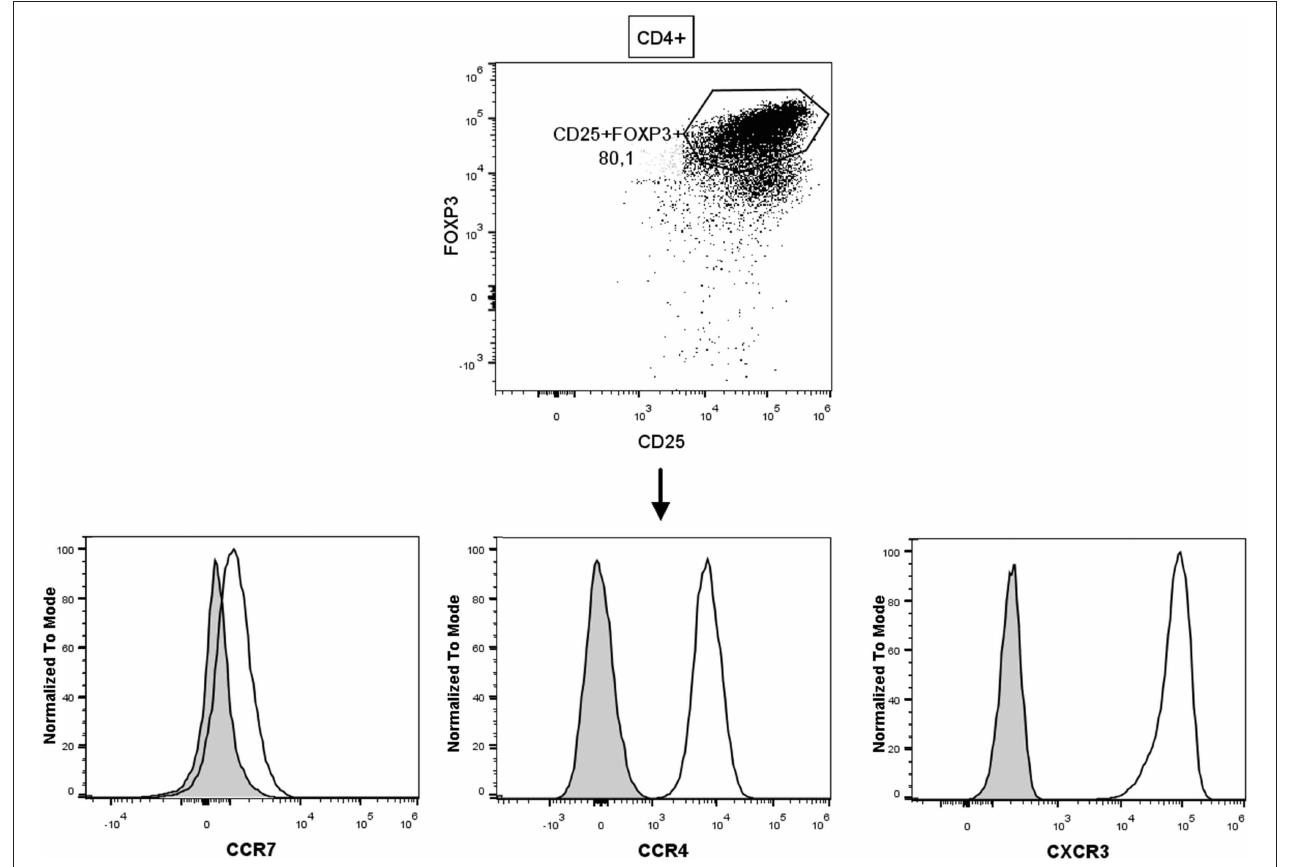
FIGURE 4 | Expanded allospecific iTregs express chemokine receptors related to migration to inflamed tissue. Representative dot plot of allospecific CD25 + FOXP3 + iTregs expanded for 28 days. Histograms show the expression level of each chemokine receptor (CCR7, CCR4, and CXCR3) from allospecific iTregs (black solid line); filled histograms denote a fluorescence minus one control (FMO). Data are representative of at least five different healthy